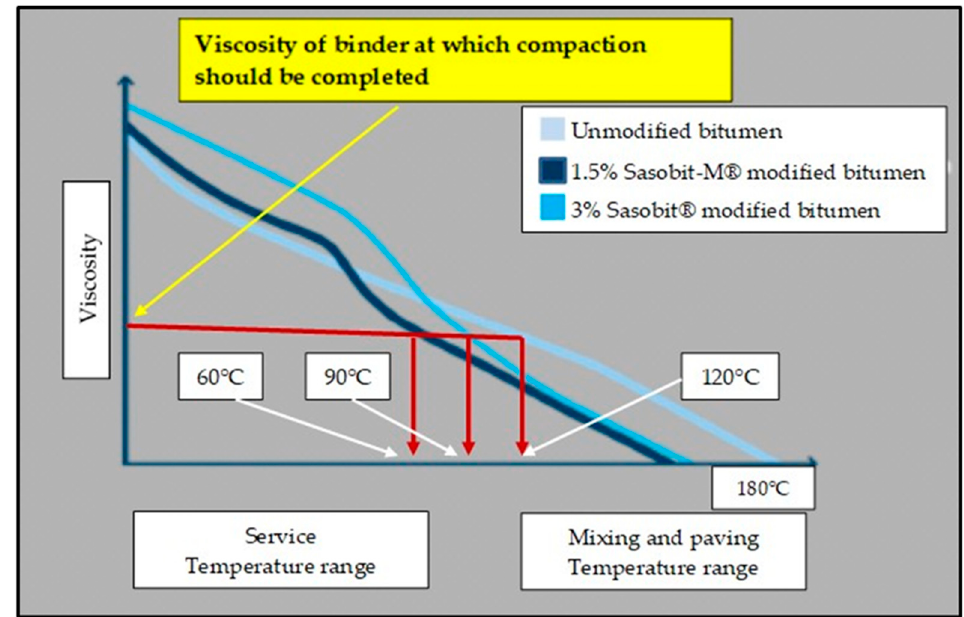
Figure 3. Working principles as applicable to a standard pen bitumen, 1.5% SASOBIT-M ® -modified bitumen and 3% SASOBIT ® -modified bitumen binder.